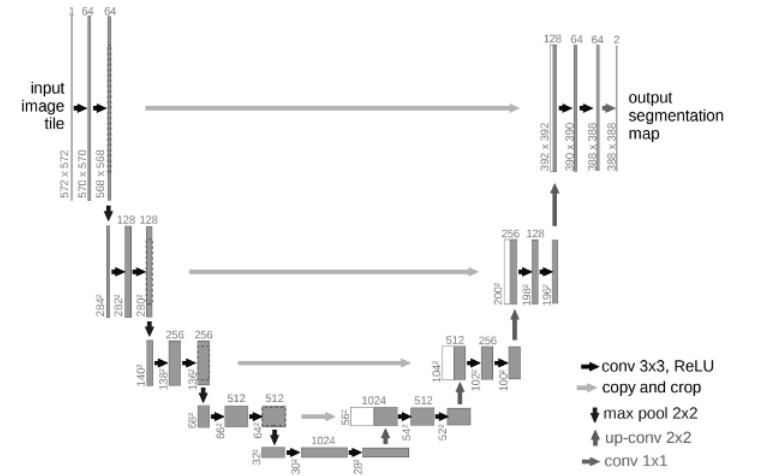
Fig. 5. U-Net CNN Model